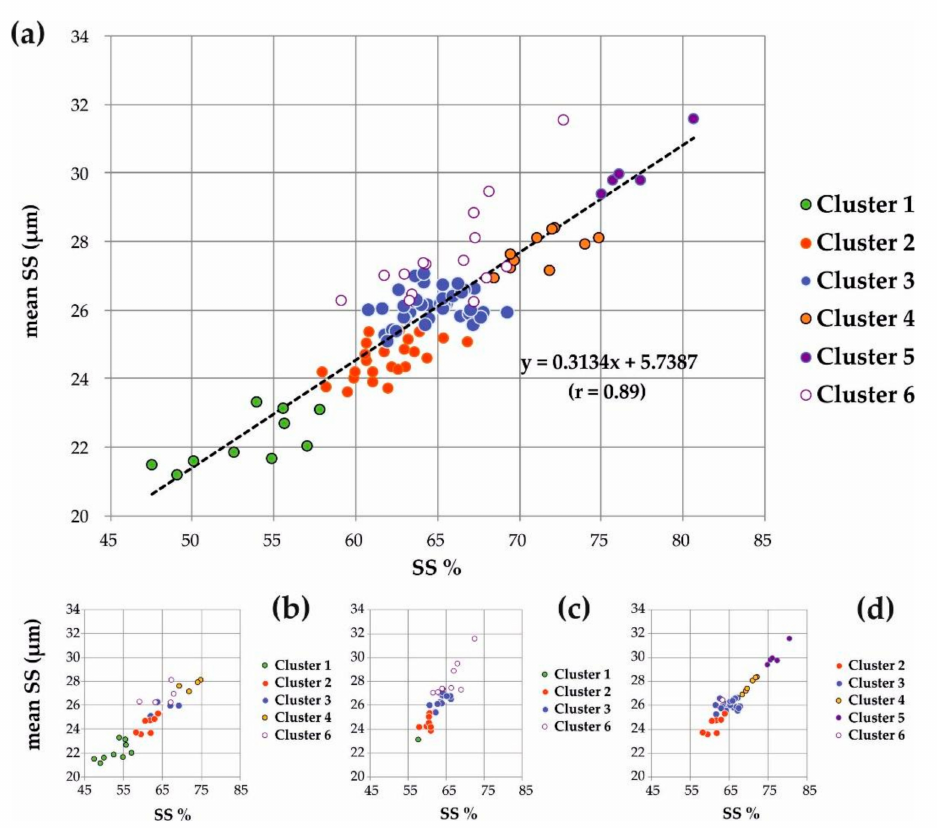
Figure 5. Relationship between mean SS and SS% for ( a ) the whole sediment dataset, ( b ) core BC02, ( c ) core BC03, and ( d ) core BC04, according to the different clusters.